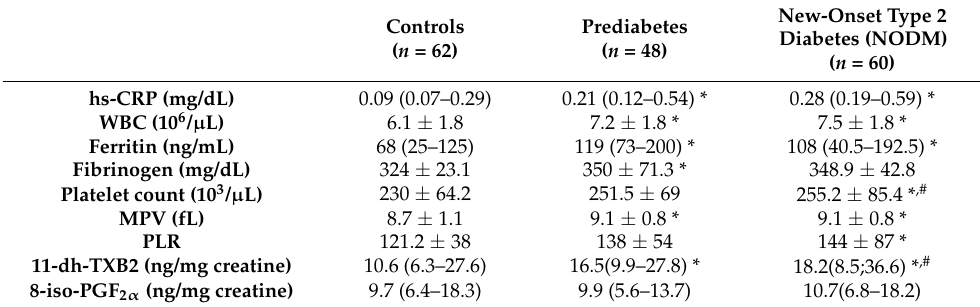
Table 2. Inflammation and platelet activation indexes in the study population according to glucose